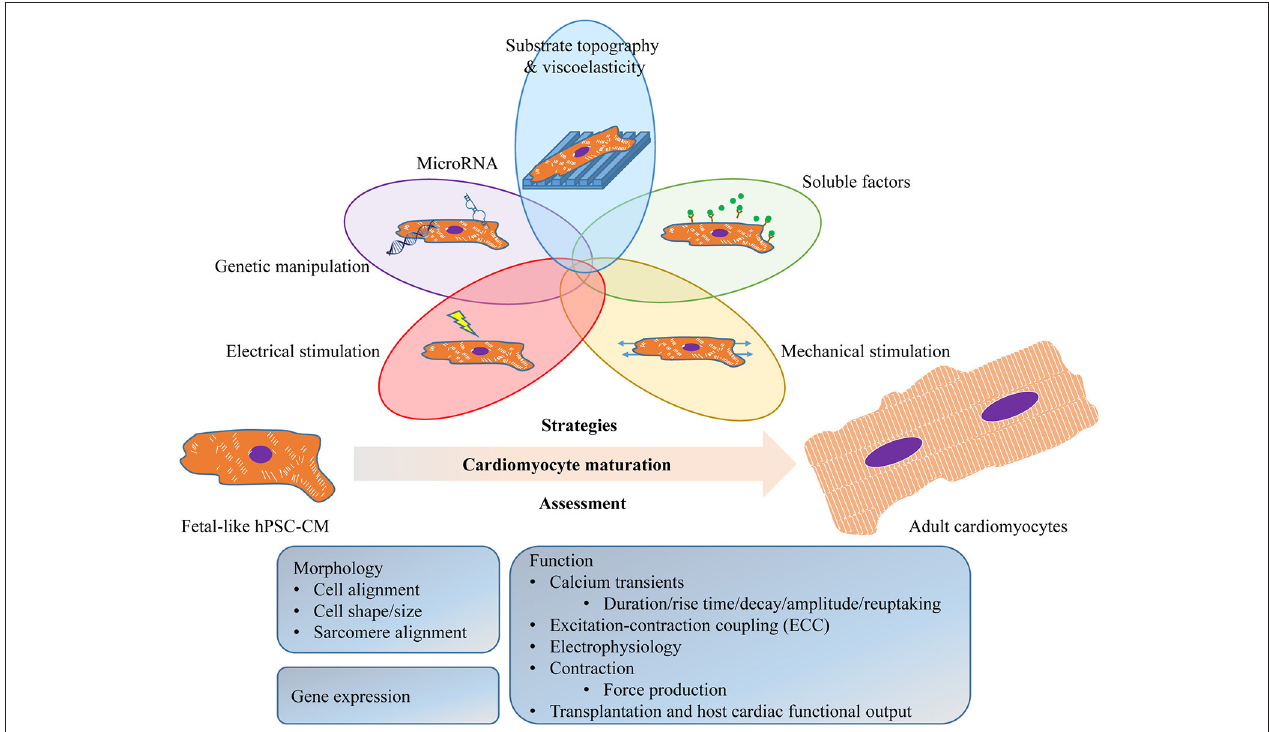
FIGURE 1 | Schematic diagram illustrating the strategies to promote and the assessment of the maturation of human pluripotent stem cell (hPSC)-derived cardiomyocytes (hPSC-CM). These approaches may be used individually or in any combination to promote hPSC-CM maturation. The assessment of the maturation should be physiologically relevant, including readout from morphology (cell alignment, cell shape/size, sarcomeres and T-tubules), gene expression (sarcomeric, ion channels and their regulators), and function (calcium handling, ECC, electrophysiology, contraction and transplantation).